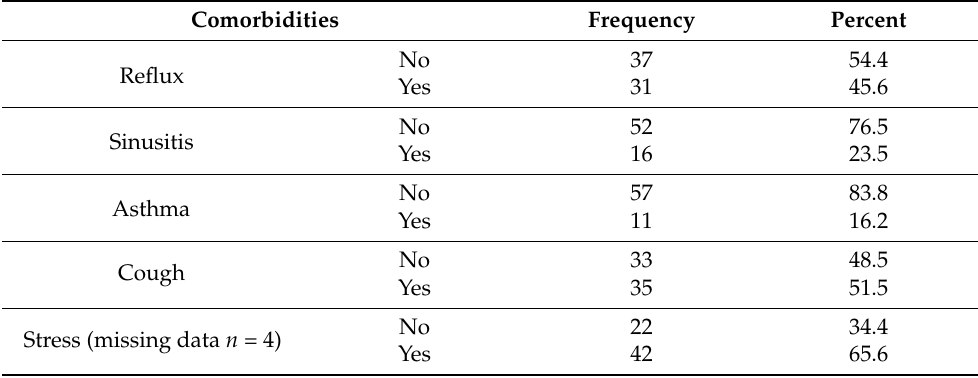
Table A2. History of voice-related comorbidities.